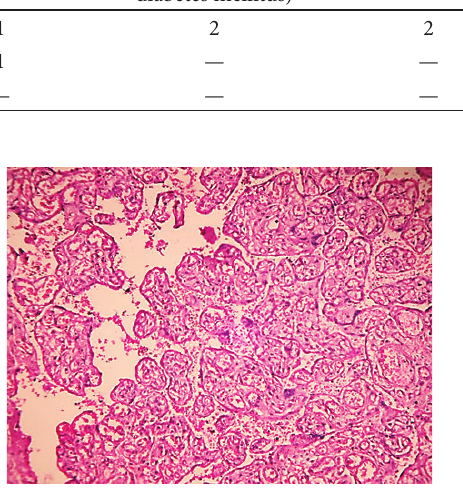
Figure 1: Placental tissue from an anemic mother displaying cho- rangiosis: H&E; 100x.